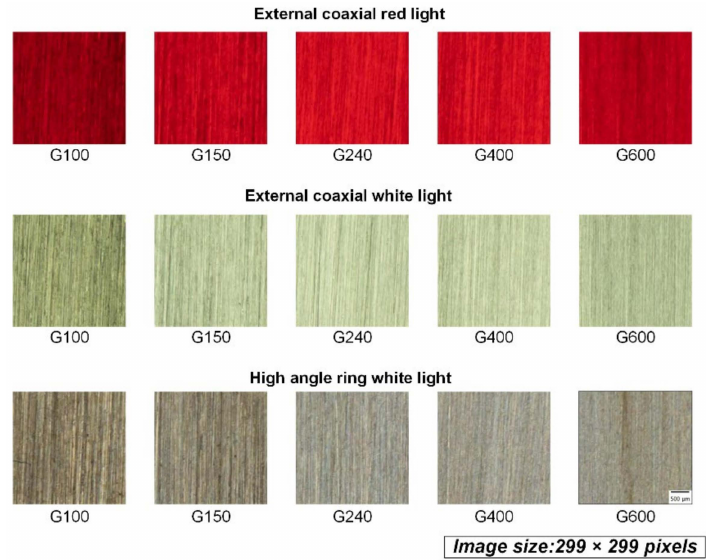
Figure 5. The images of the workpiece after the first-step cropping of the raw images. X1 and X2 represent one-direction grinding and two-orthogonal-direction grinding, respectively.